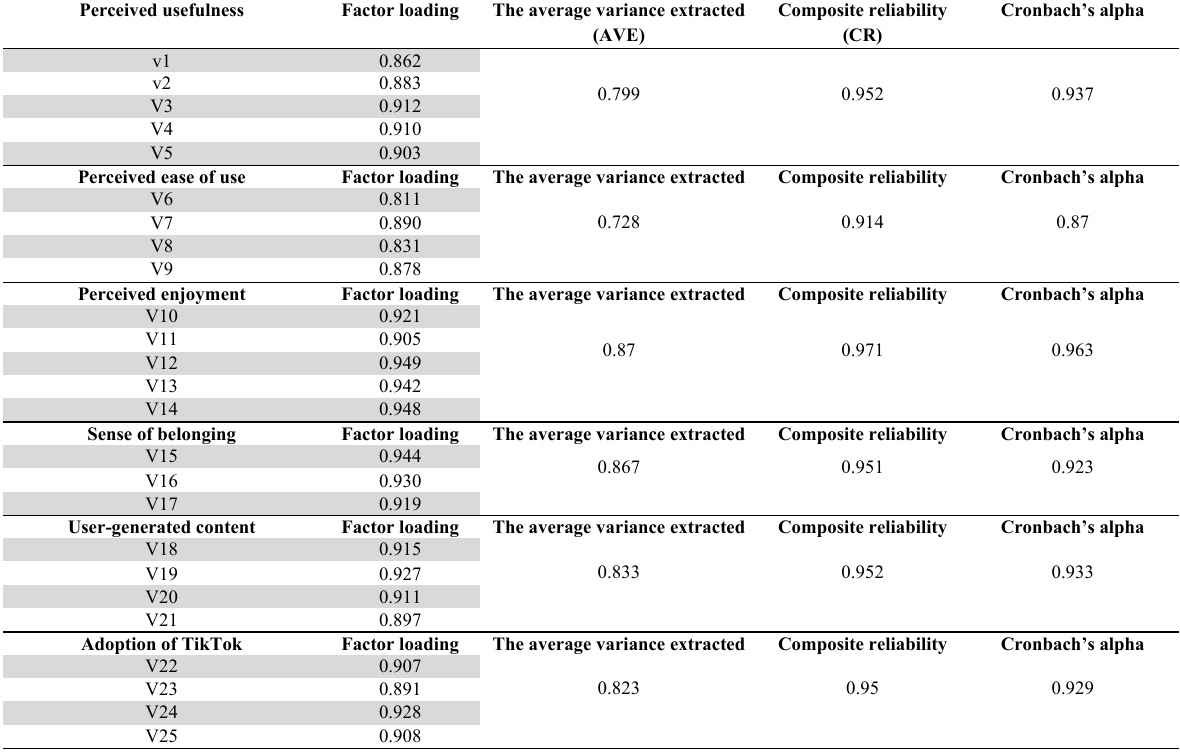
Internal Consistency and Convergent